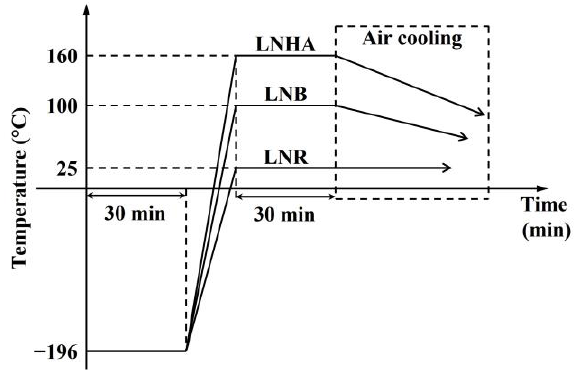
Figure 1. Three uphill quenching processes.